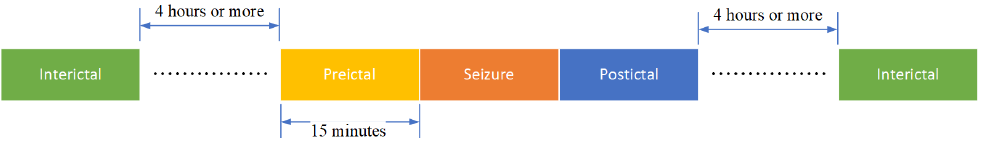
Figure 2. All stages of epileptic EEG